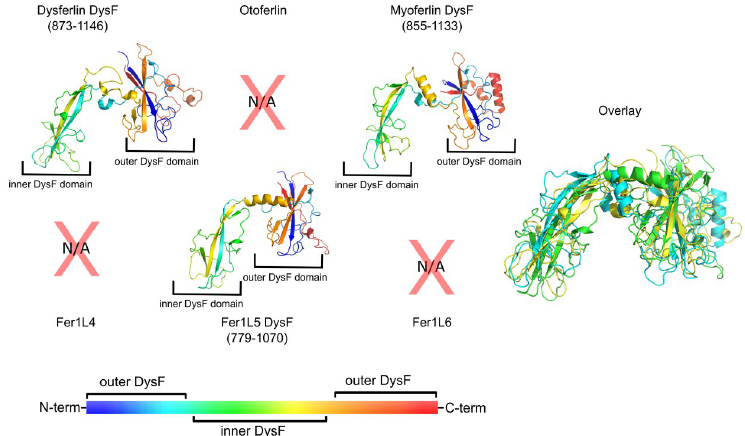
Fig 8. Models of the complete DysF region of the Type-1 ferlins; dysferlin, myoferlin, and Fer1L5. The inner DysF domain is positioned at the left of each model, whereas the outer domain is positioned on the right side. The models of the complete DysF region have been colored as a gradient from blue to red to highlight the crossover topology of the outer DysF domain’s fold. The color bar illustrates the progression of colors from N-terminus to C-terminus. The superposition of each of the Type-1 Ferlin DysF domains is labeled as